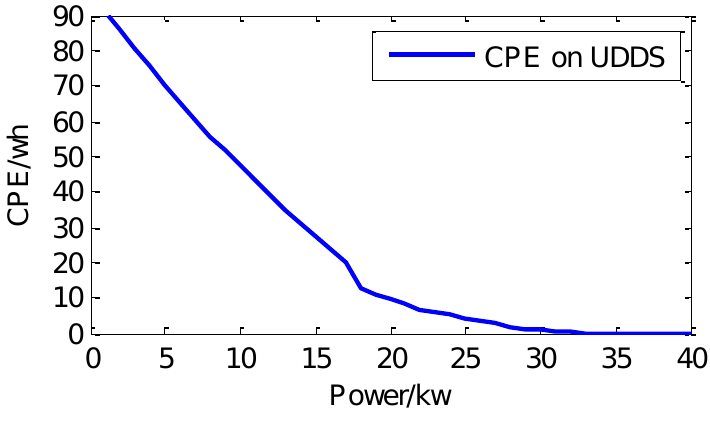
Figure 5. CPE result on UDDS.